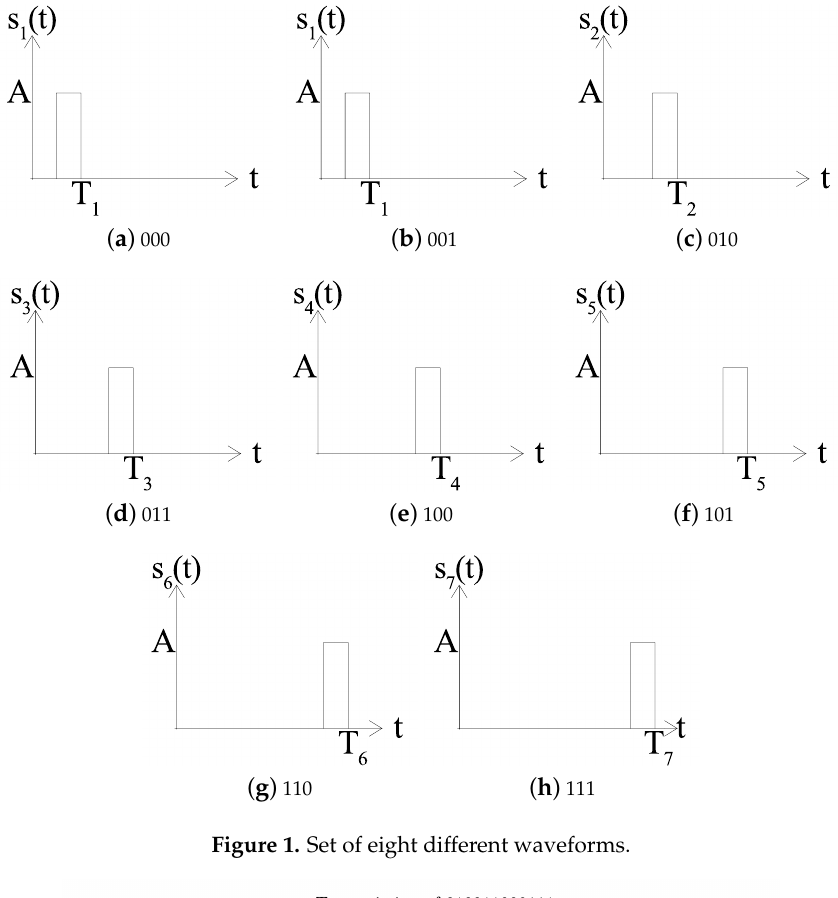
Figure 1. Set of eight different waveforms.